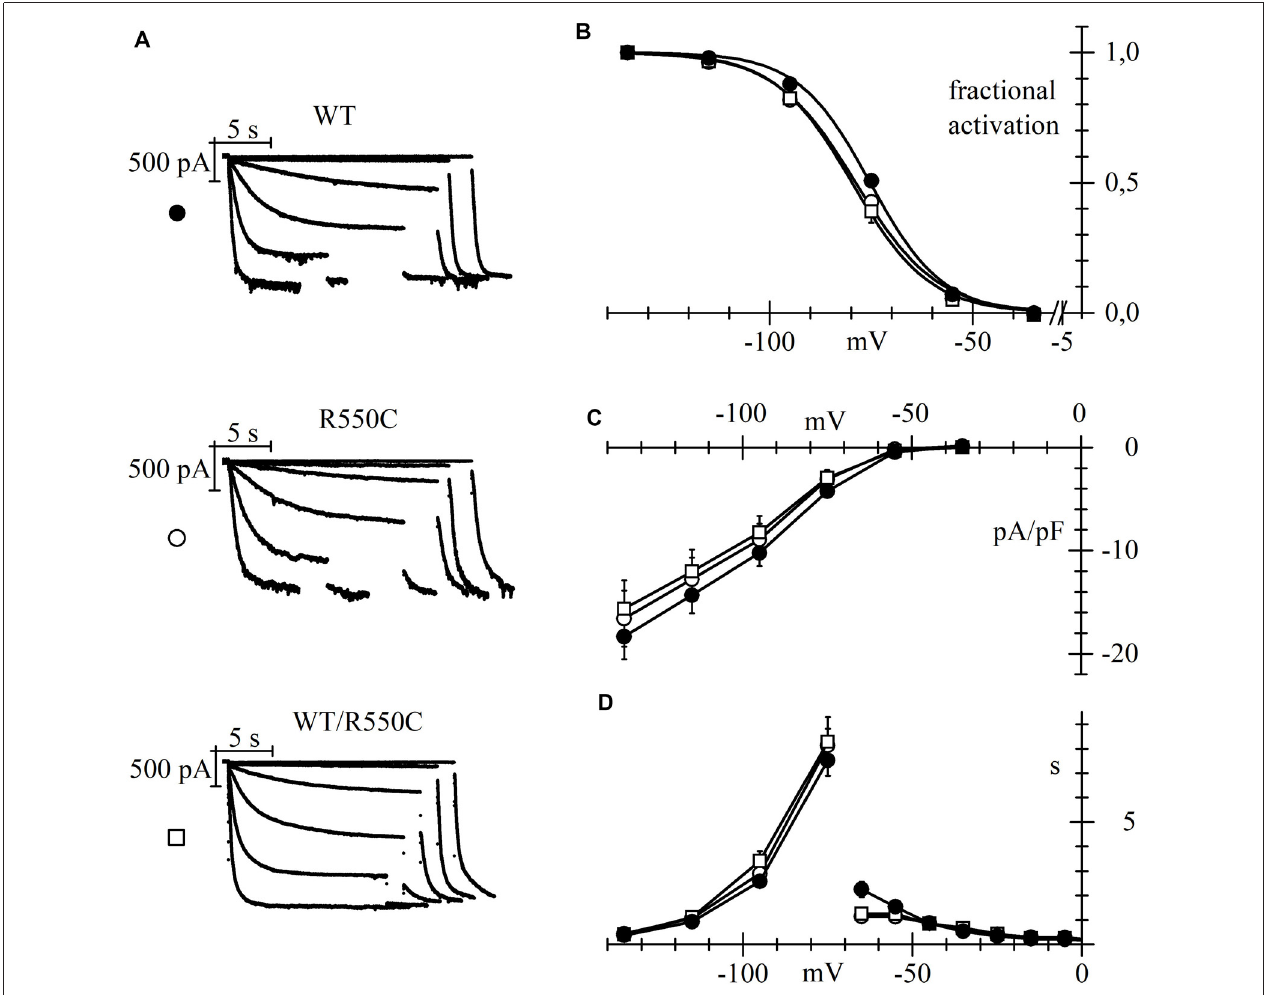
FIGURE 2 | The R550C mutation causes a shift of the activation voltage-dependence of HCN4 expressed in CHO cells. (A) Representative hHCN4 current traces recorded during a two-step activation protocol (test range − 35/ − 135 mV, holding potential (hp) = − 30 mV) in CHO cells transfected with either wild-type (WT), R550C or WT/R550C hHCN4, as indicated. (B) Plot of the mean activation curves of hHCN4 currents (WT, filled circles; R550C, open circles; WT/R550C, open squares). Mutated channels had a slightly, but statistically significant, more negative range of activation than WT channels. V 1 / 2 and s values from Boltzmann curve fitting were (mV): WT, − 74.9 ± 1.0, 8.52 ± 0.38 ( n = 33); R550C, − 79.1 ± 1.0, 9.41 ± 0.47 ( n = 29); WT/R550C, − 79.5 ± 1.7, 8.50 ± 0.42 ( n = 20). (C) I/V density curves. Current densities at − 135 mV were (pA/pF): WT, − 18.3 ± 2.2 ( n = 24); R550C, − 16.6 ± 2.7 ( n = 22); WT/R550C, − 15.6 ± 2.8 ( n = 17). (D) Mean time